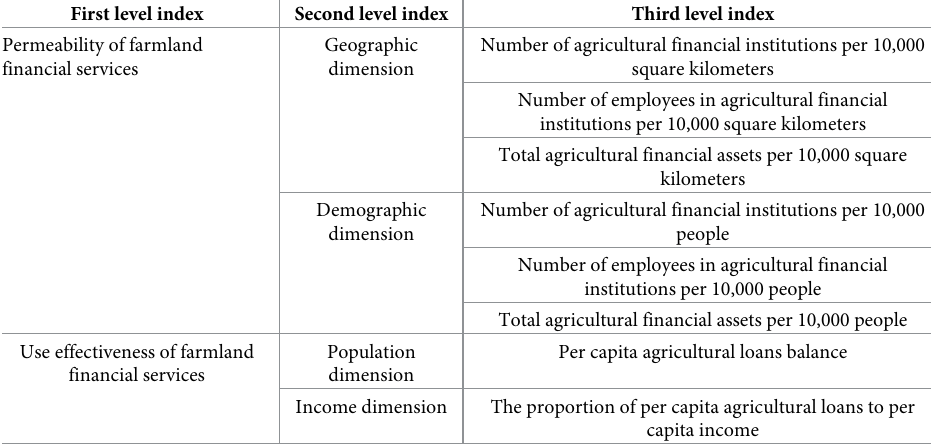
Table 1. Evaluation index system of farmland financial innovation in